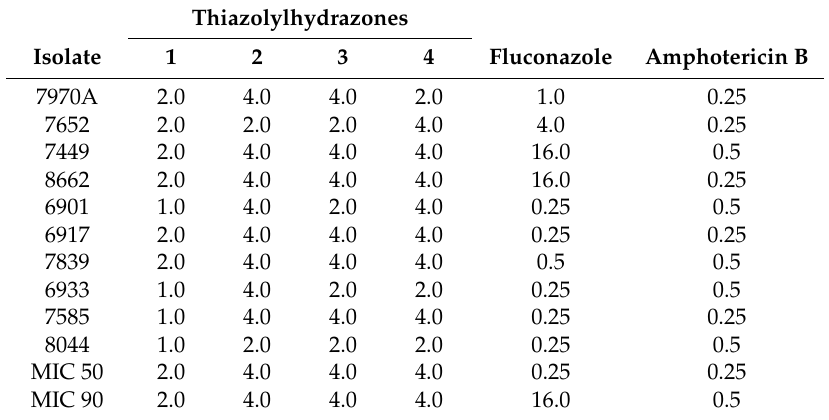
Table 3. MIC * of thiazolylhydrazones compounds against Candida parapsilosis isolates. Thiazolylhydrazones